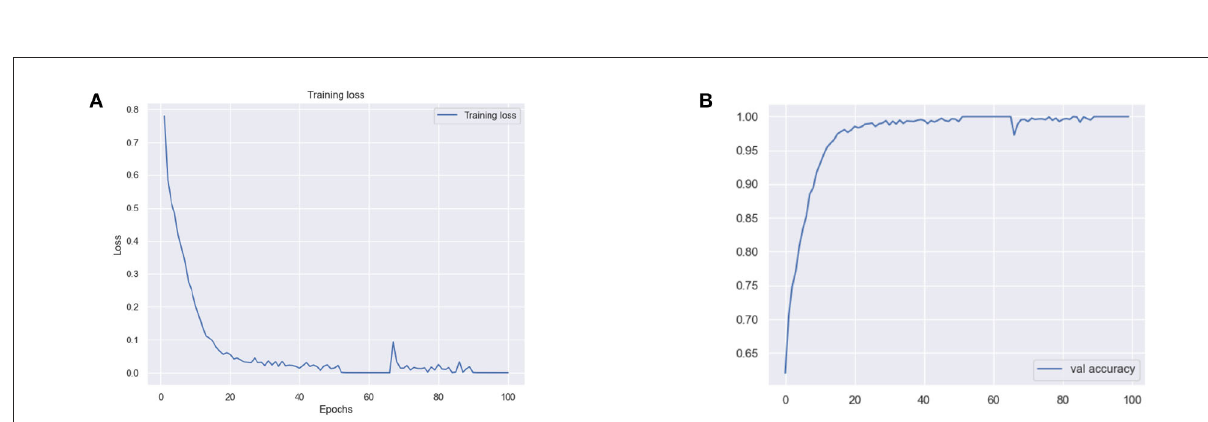
FIGURE6 (A) Training loss and (B) validation (val) accuracy of the VGG 19 model with additional layer and freezing the